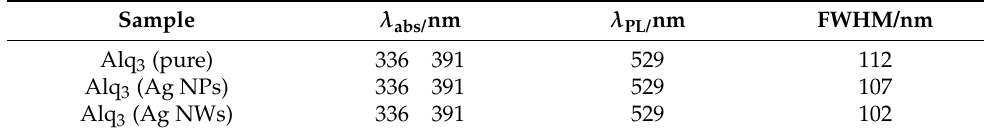
Figure 3. ( a ) PL spectra of Alq 3 (pure), Alq 3 (Ag NPs) and Alq 3 (Ag NWs); the bi-directional arrow lines represent the FWHM of samples; ( b ) PL enhancement ratio as a function of wavelength. Table 1. Spectral parameters obtained from absorption and PL spectra at room temperature.